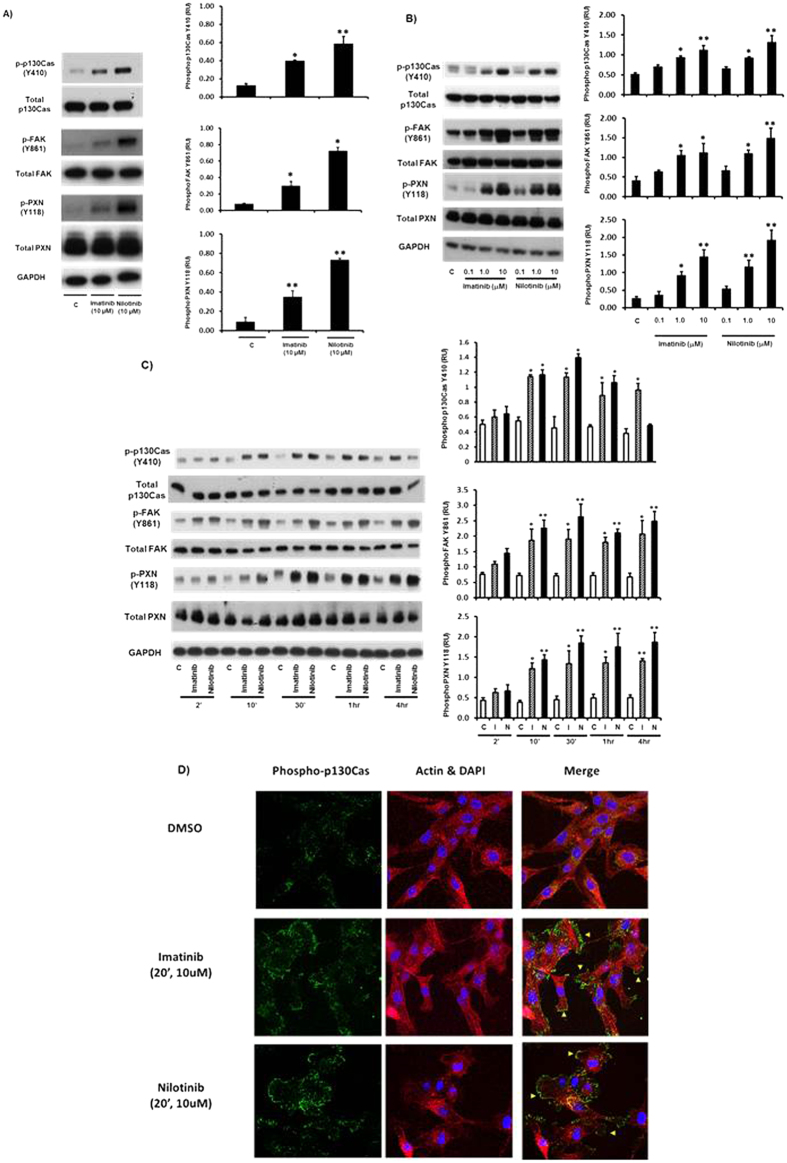
Imatinib and nilotinib treatment of human GBM cells leads to increased p130Cas, Focal Adhesion Kinase (FAK) and Paxillin (PXN) tyrosine phosphorylation. Cells (~80% confluent) were incubated in SFM for ~18 hr prior to treatment with either SFM & DMSO vehicle control (C), or imatinib or nilotinib at the indicated concentrations and times. Cell lysates were then prepared, blotted, and probed with the indicated antibodies. Blots shown here and in all subsequent figures unless indicated are representative of at least three separate experiments. (A), U87MG cells were treated with vehicle control (C), or 10 μM imatinib or 10 μM nilotinib for 20 minutes. (B), Dose dependency of imatinib or nilotinib treatment for 20 minutes in U87MG cells. (C), Time course of U87MG cells treated with vehicle control (C), or 10 μM imatinib or 10 μM nilotinib. Quantitation of tyrosine phosphorylation was performed by densitometry using Image J. In each panel, data from at least three independent experiments are presented as phosphorylation relative units (RU) (means +/− s.e.m.) normalized to total protein levels; *p < 0.05, **p < 0.01 compared to vehicle control (C). #p > 0.05 compared to vehicle control (C). (D), U87MG cells were seeded on glass cover slips and incubated in SFM for ~18 h prior to for 20 min with vehicle control (C), or 10 μM imatinib or 10 μM nilotinib. Confocal imaging was performed as described in Materials and Methods, with phosphorylated p130Cas (Y410) staining in green, actin in Red and DAPI in purple. Images are representative of at least three separate experiments. Arrows point to areas of increased p130Cas (pY410) localisation to the membrane upon treatment.